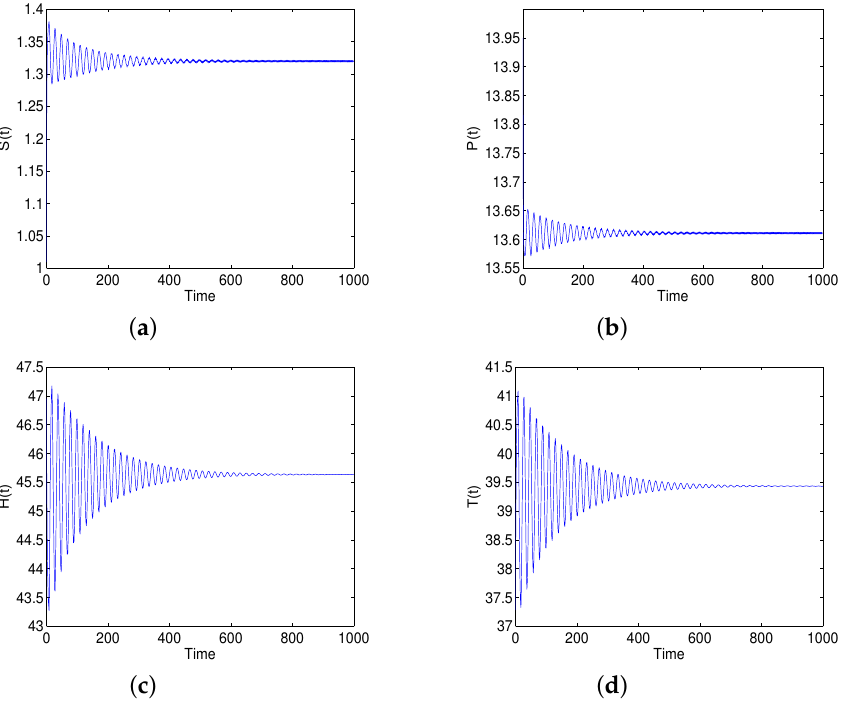
Figure 1. The time plot of ( a ) susceptible population, ( b ) psychological addicts, ( c ) physiological addicts and ( d ) drug-users in treatment for τ 1 = 8.2247 < τ 10 = 9.7367 with A = 2, d = 0.02, β 1 = 0.016, β 2 = 0.028, π = 0.03, γ = 0.095, θ = 0.5 and σ = 0.21.